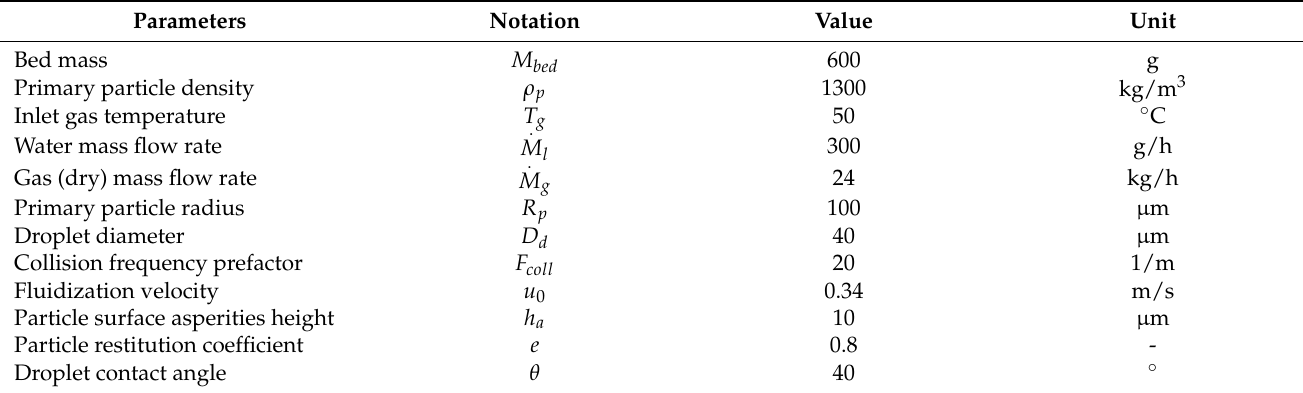
Table 3. The experimental and simulation parameters.